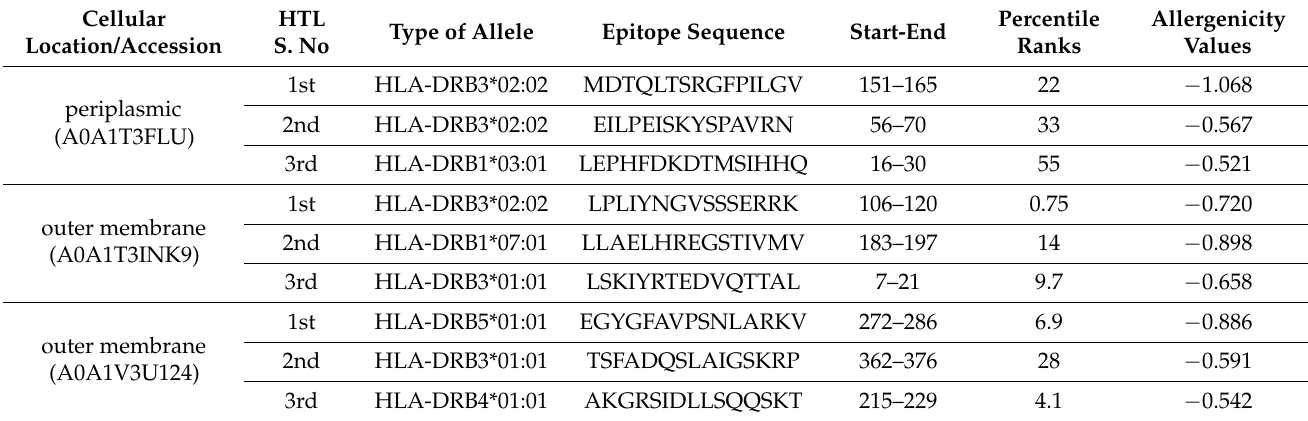
Table 3. The helper T-cell epitope predicted for each of the selected proteins of E. meningoseptica with information, including their peptide length, percentile rank, position, and important parameters.